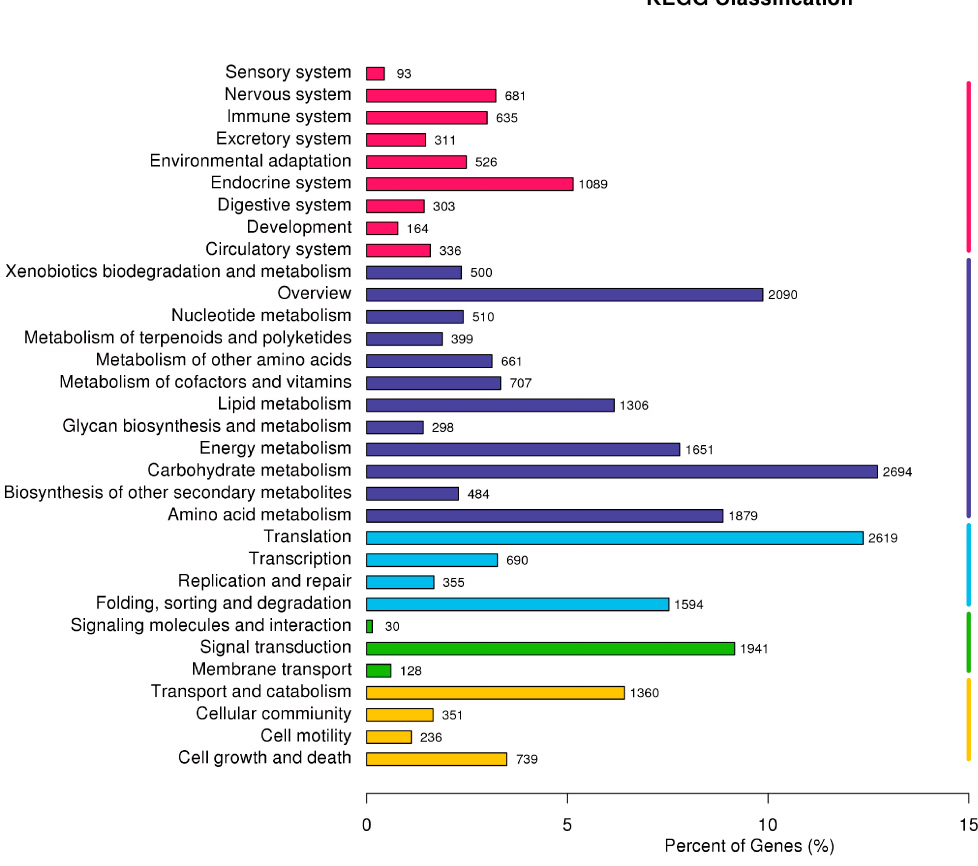
Figure 5. Pathway assignment based on the Kyoto Encyclopedia of Genes and Genomes (KEGG). Pathway assignment based on the Kyoto Encyclopedia of Genes and